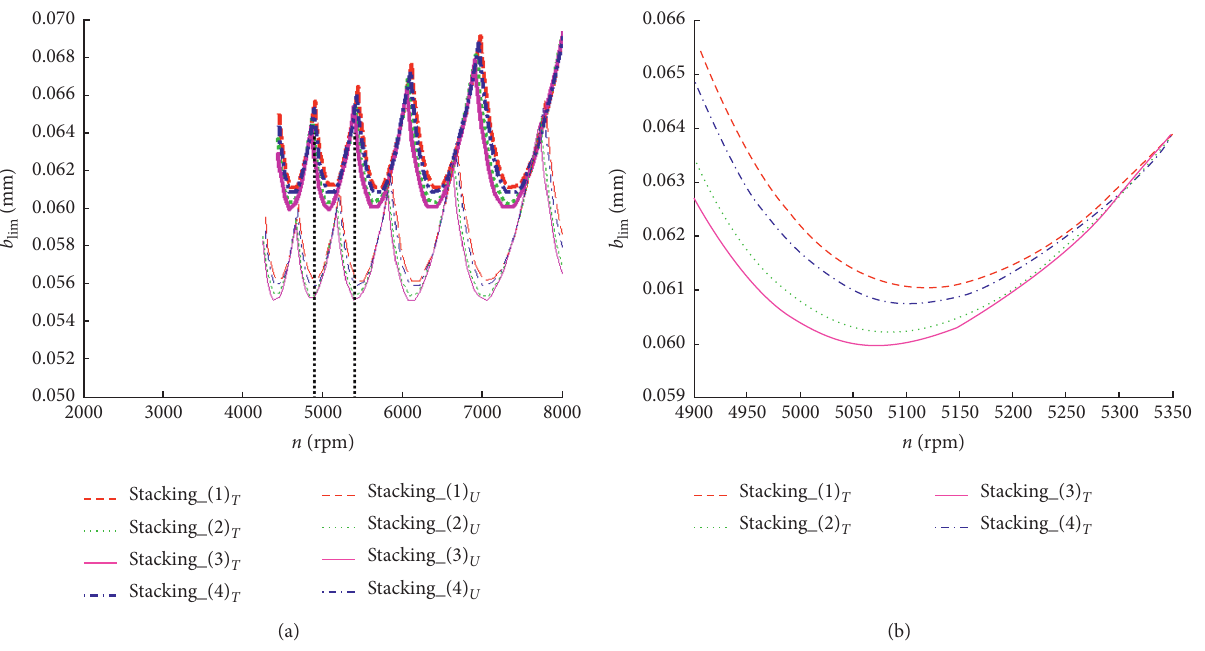
Figure 10: Effect of the stacking sequence on chatter stability.